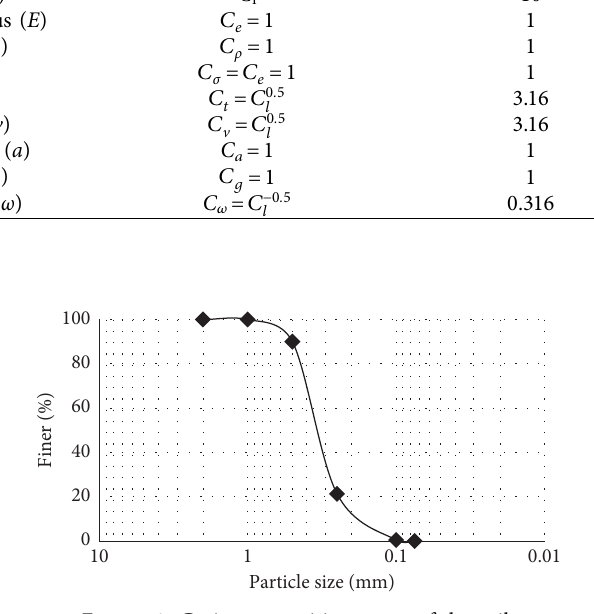
Figure 3: Grain composition curve of the soil.